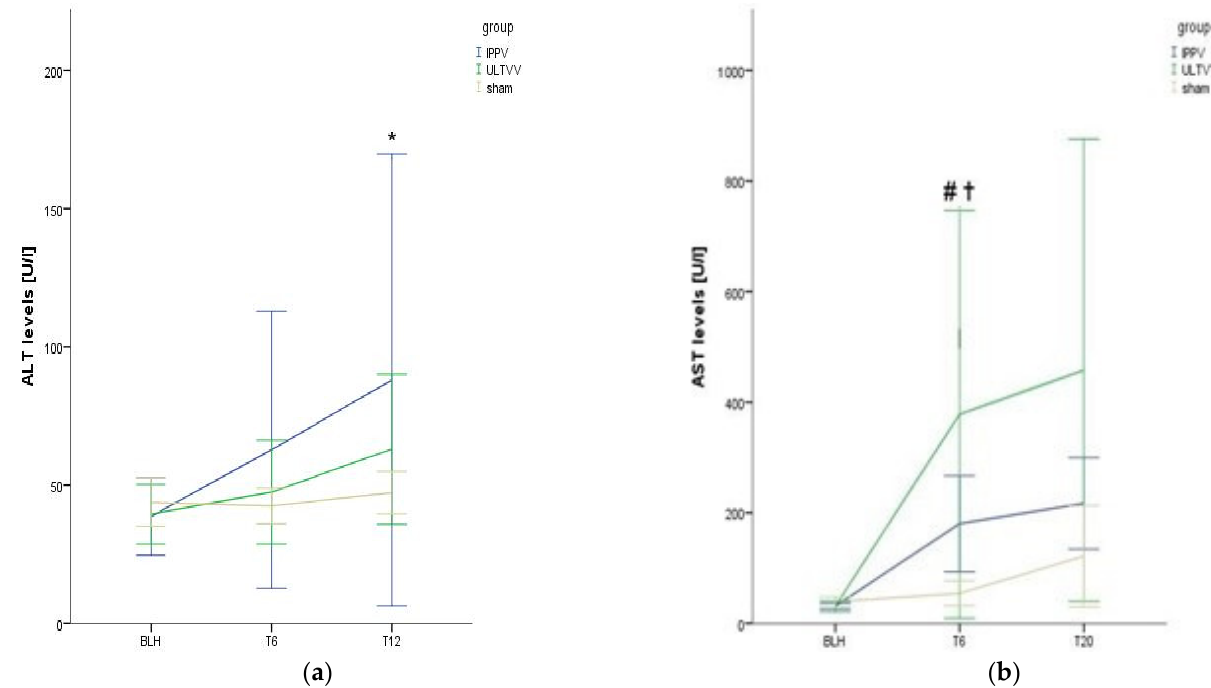
Figure 4. Levels of transaminases. ( a ) Alanine aminotransferase. ( b ) aspartate aminotransferase. Mean (±1 SE). * indicates p < 0.05 for elevated levels of alanine aminotransferase in all groups vs. baseline. # indicates p < 0.05 for IPPV vs. baseline and for IPPV vs. sham for T6. † indicates p < 0.05 for ULTVV vs. baseline and for ULTVV vs. Sham for T6. IPPV: Intermittent positive pressure ventilation. ULTVV: Ultra-low tidal volume ventilation. U/L: Units per liter. ALT Alanine Aminotransferase. AST Aspartate Aminotransferase. Tx: timepoint.